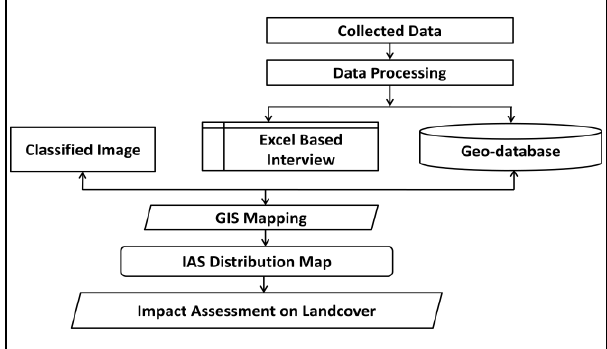
Figure 2. Work flow diagram for distribution